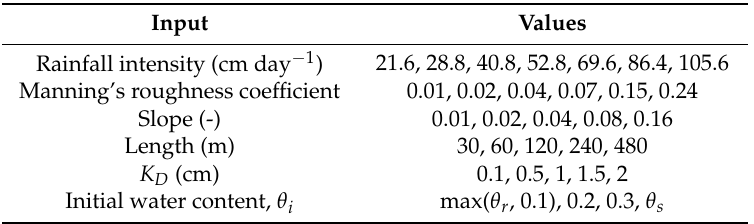
Table 1. Input parameters used in the numerical simulations.